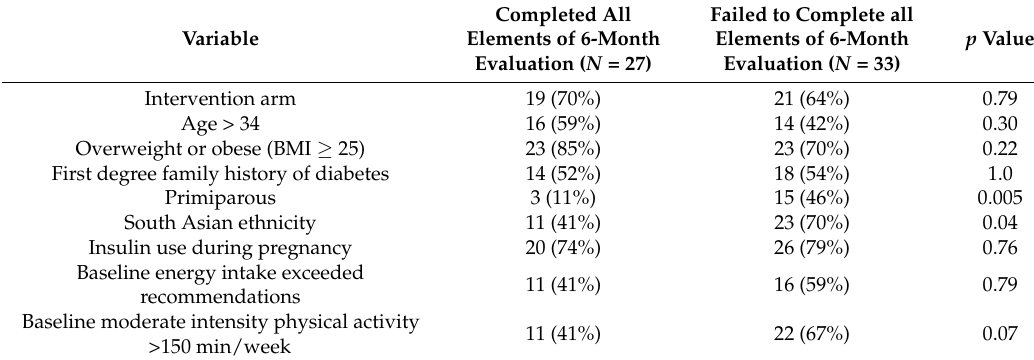
Table 6. Predictors of study completion.